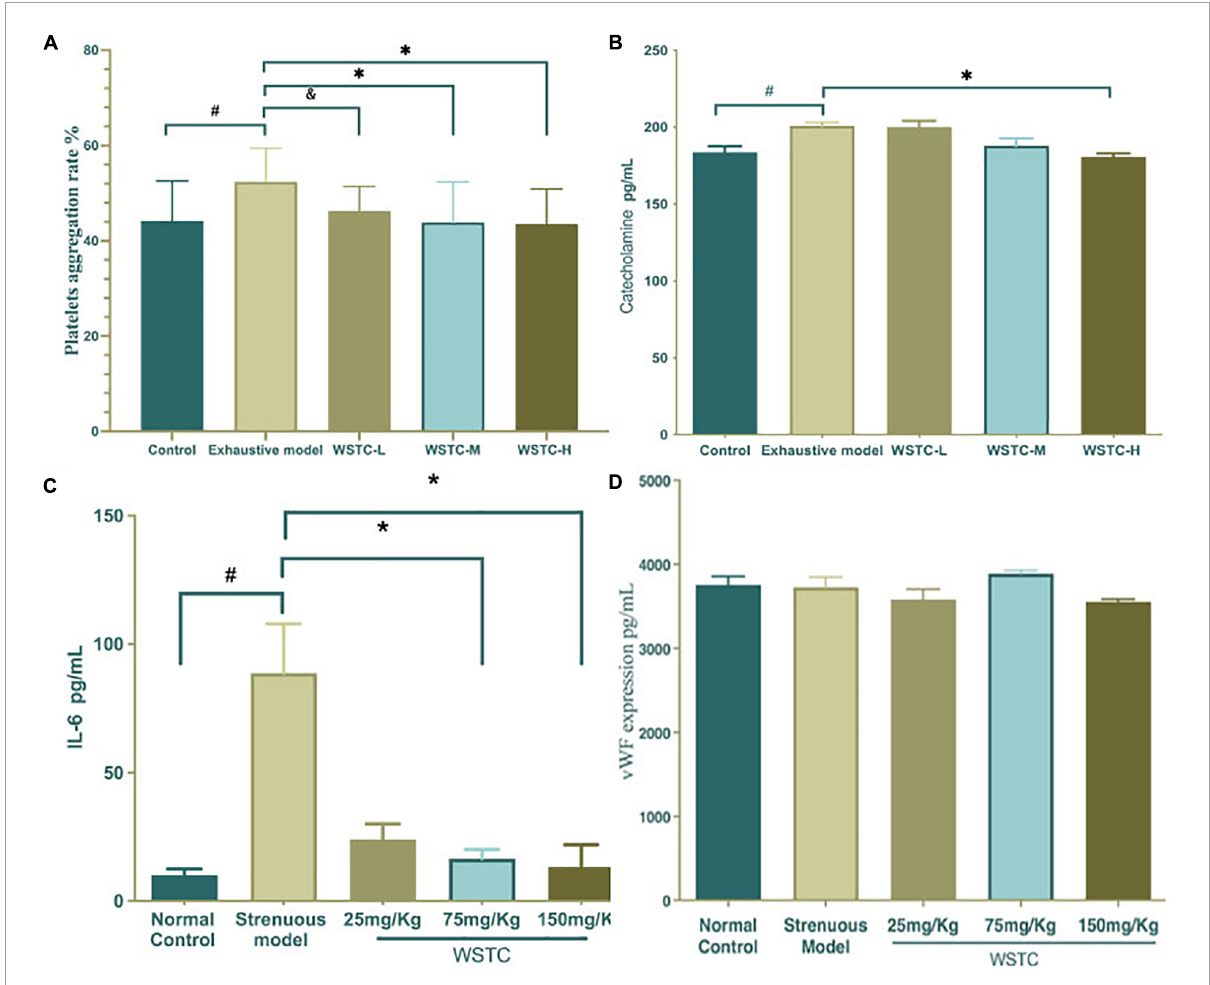
FIGURE3 Effects of water-soluble tomato concentrate (WSTC) on platelet aggregation and the plasma levels of catecholamine and vWF in rats undergoing strenuous exercise. (A) Mean platelet aggregation rate of the control group, strenuous model group, WSTC 25 mg · kg − 1 group, WSTC 75 mg · kg − 1 group, and WSTC 150 mg · kg − 1 group. All groups recorded the maximal aggregation after the addition of ADP (2.5 µ M). # P < 0.05 compared to control group; & P < 0.10 compared to exhausted e model group; (B) Levels of plasma catecholamine in the control group, strenuous model group, WSTC 25 mg · kg − 1 group, WSTC 75 mg · kg − 1 group, and WSTC 150 mg · kg − 1 group. # P < 0.05 compared to control group; ∗ P < 0.05, compared to strenuous model group. (C) Levels of plasma IL-6 in the control group, strenuous model group, WSTC 25 mg · kg − 1 group, WSTC 75 mg · kg − 1 group, and WSTC 150 mg · kg − 1 group. # P < 0.05 compared to control group; ∗ P < 0.05, compared to strenuous model group. (D) Levels of plasma vWF in the control group, strenuous model group, WSTC 25 mg · kg − 1 group, WSTC 75 mg · kg − 1 group, and WSTC 150 mg · kg − 1 group.